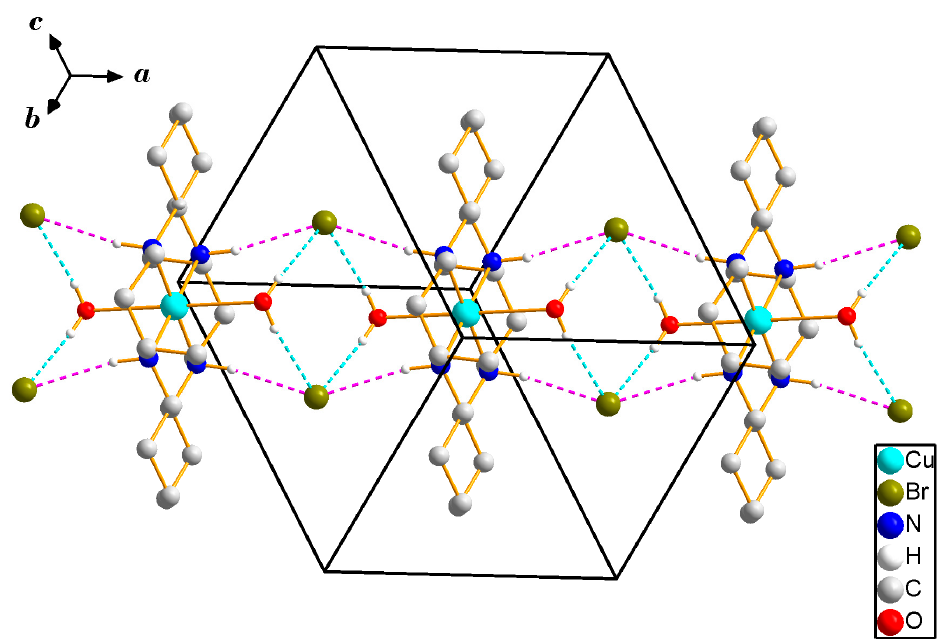
Figure 2. Crystal packing diagram of complex (I). Dashed lines represent hydrogen bonds. Crystals 2019 , 9 , x FOR PEER REVIEW